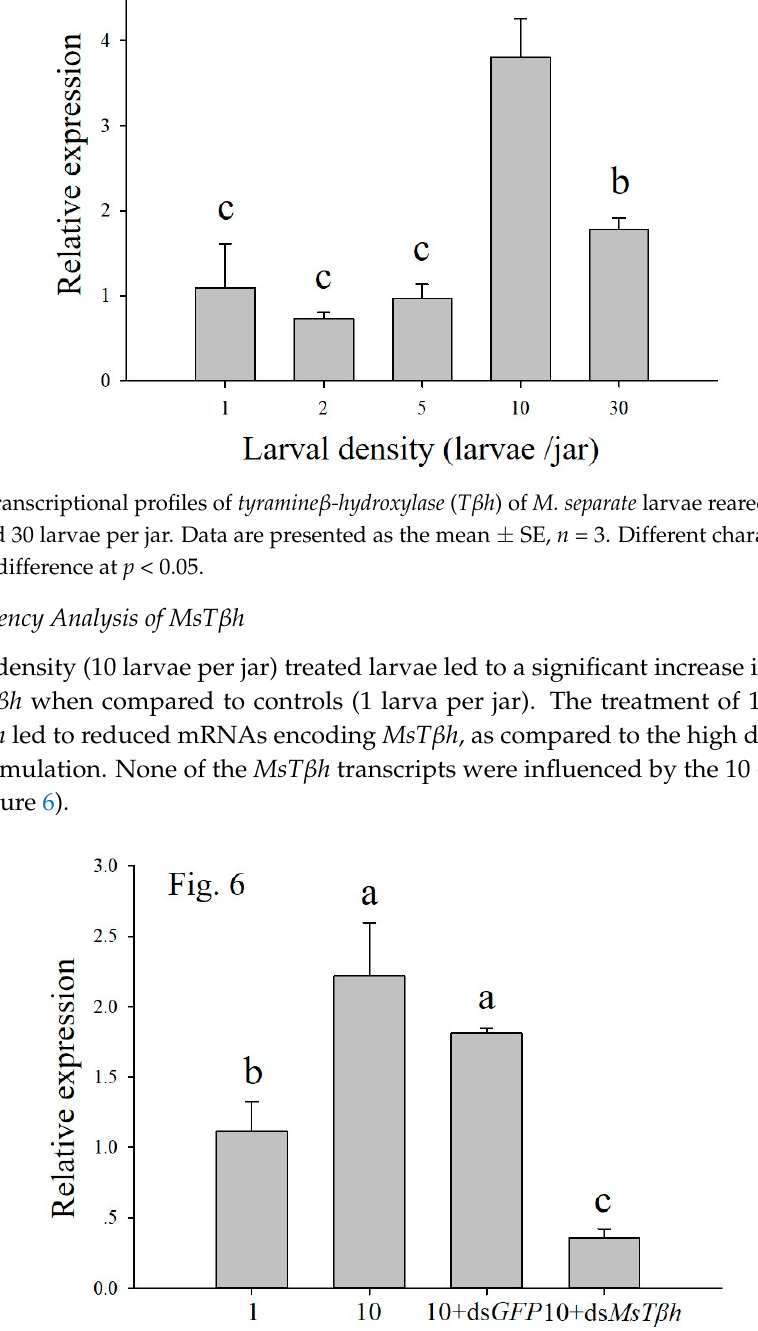
Figure 6. Effects of high density (10 larvae per jar) and 10 + ds MsT β h silencing on the tyramine β - hydroxylase ( T β h ) transcript level of M. separate larvae. ds GFP has been as control. Data are presented as the mean ± SE, n = 3. Different characters denote significant difference at p < 0.05.